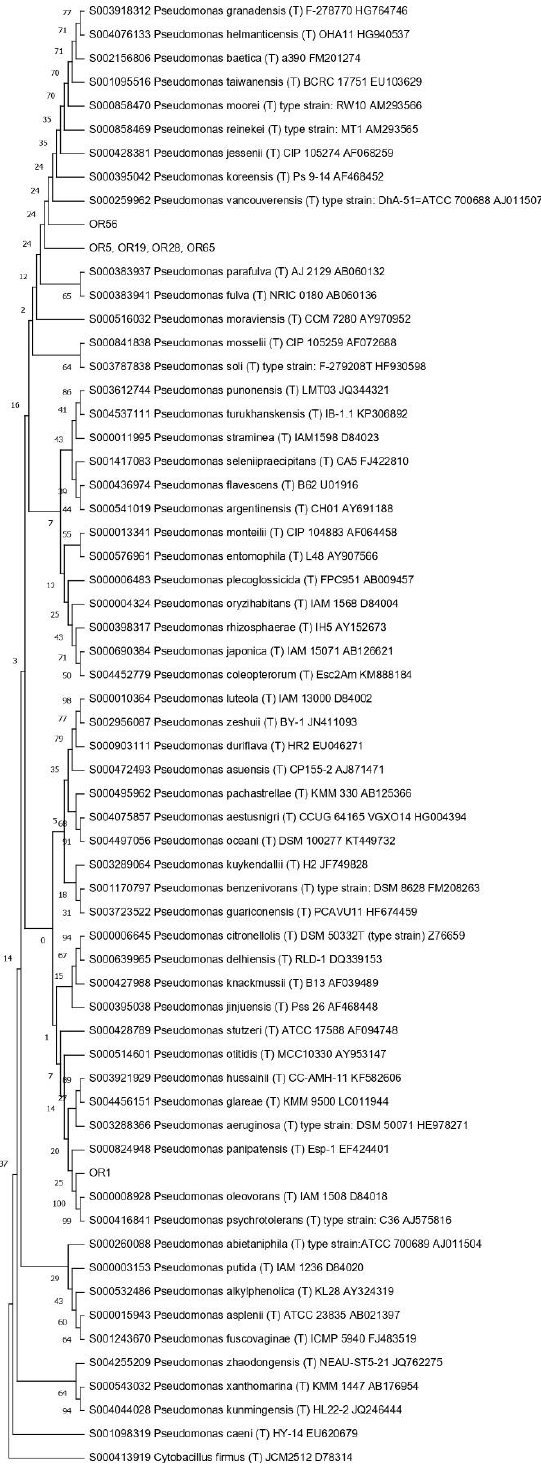
Figure 9. Phylogenetic tree for the genus Pseudomonas.